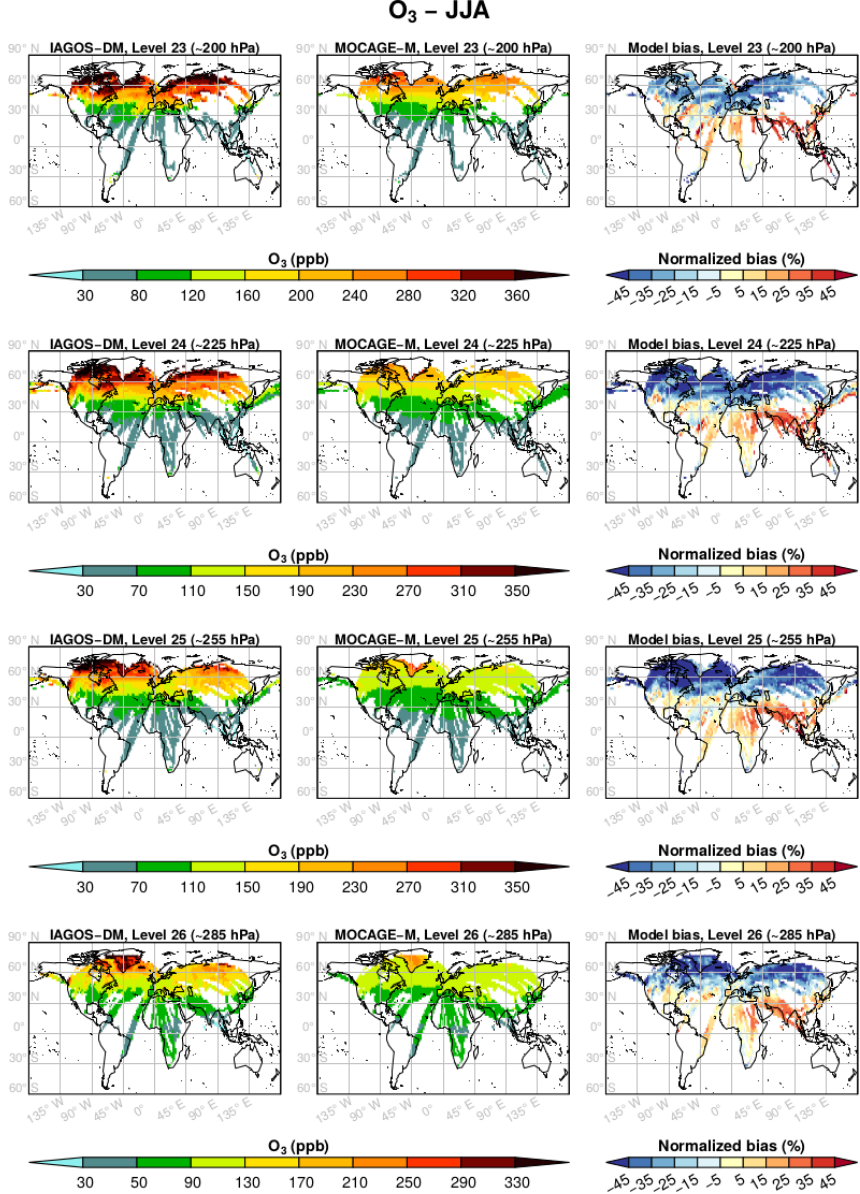
Figure A3. As Fig. 3 for boreal